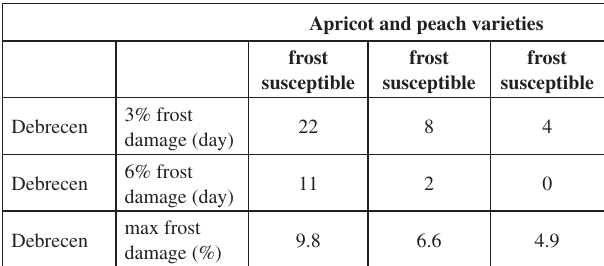
Table 2 – Occurrence of frost damage of increasing severity in apricot and peach varieties of different susceptibility during the rest period (Debrecen, 1951–2010)